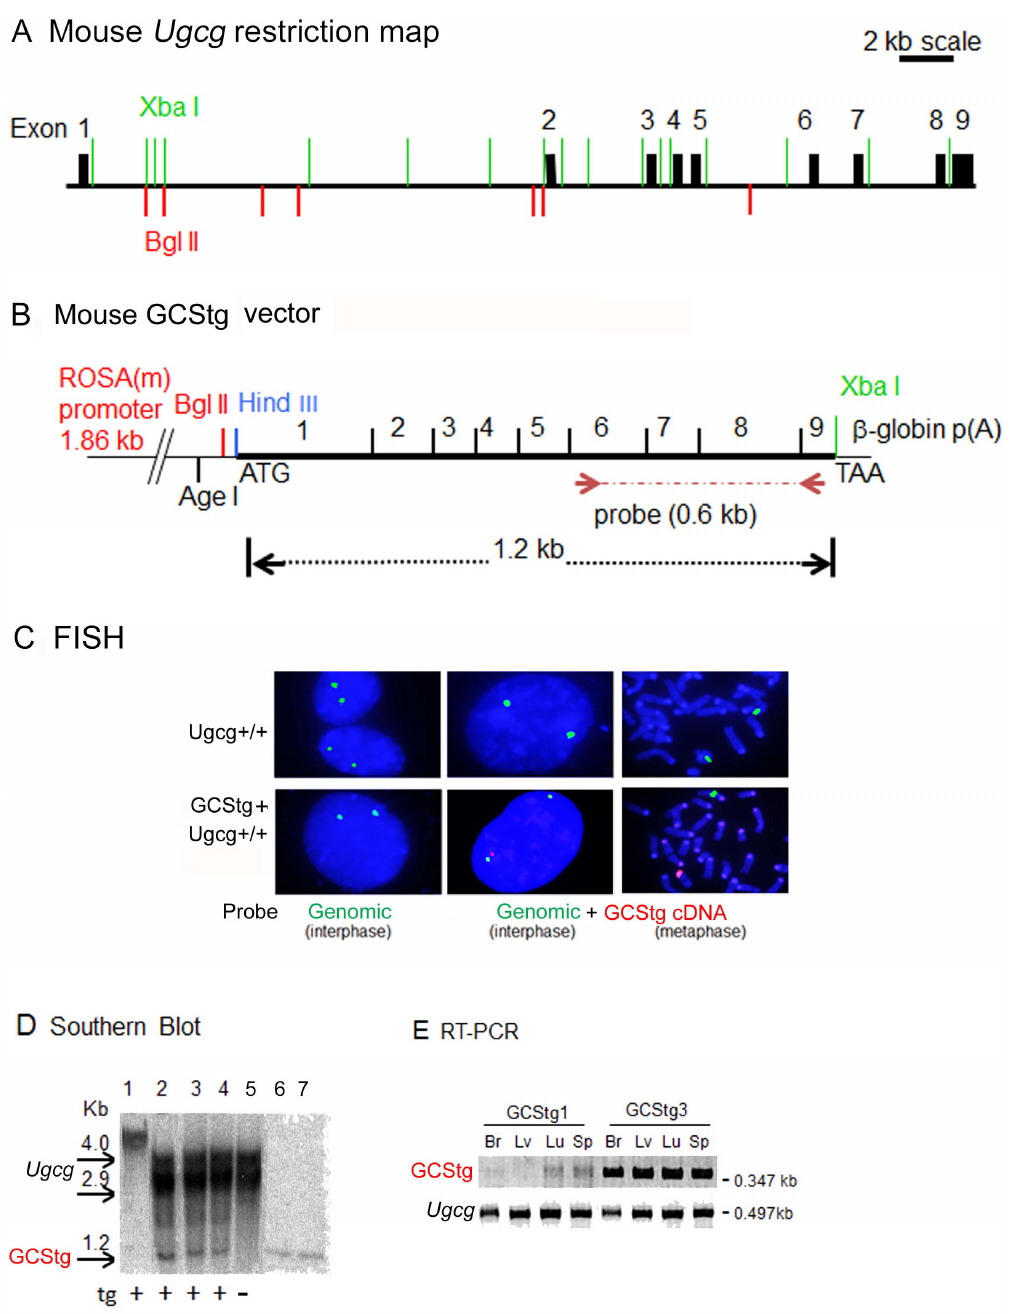
Fig. 1. GCS transgene integration and expression. (A) Xba I/Bgl II restriction mapping of the mouse Ugcg (GCS) gene. Ugcg gene spans 33.5 kb of length and contains 9 exons (solid blocks). The scale bar is 2 kb. (B) The mouse GCS cDNA transgene was cloned into the Hind III/Xba I sites of pBROAD vector containing the ubiquitously expressed ROSA26 promoter and b -globin poly(A) sequence. Arrows show the position of 0.6 kb cDNA probe (exons 6 - 9) for Southern blotting. (C) Fluorescence in situ hybridization (FISH) study. Fibroblasts from WT ( Ugcg + / + ) (upper panels) and GCStg mice (lower panels) were processed for FISH analysis using both genomic BAC probe RP23 (green, for endogenous Ugcg loci) and GCS cDNA probe (red, for GCStg) as indicated. (D) Southern blot analysis. 20 m g of tail DNA from GCS transgene positive ( + ) or negative ( 2 ) mice were digested by restriction enzymes Xba I and Bgl II and processed for Southern blotting using 0.6 kb [ 32 P]-GCS cDNA probe (shown in B). Lanes 1 to 5 from GCStg lines, Lane 1, no Xba I/Bgl II digestion; lane 2 to 5 (GCStg line 1, 3, 9, 10), with Xba I/Bgl II digestion; lane 6 and 7, 1 x or 2 x copy number of 1.2 kb GCS cDNA fragment loaded on the gel. Images of 1.2 kb GCS cDNA bands on Southern blot were quantitated using Image J 1.47V software (NIH, USA). (E) RT-PCR analysis of GCS transgene expression. RNAs from mouse tissues of 2 transgenic mouse lines (GCStg1 and GCStg3) were conducted for RT-PCR using GCStg specific